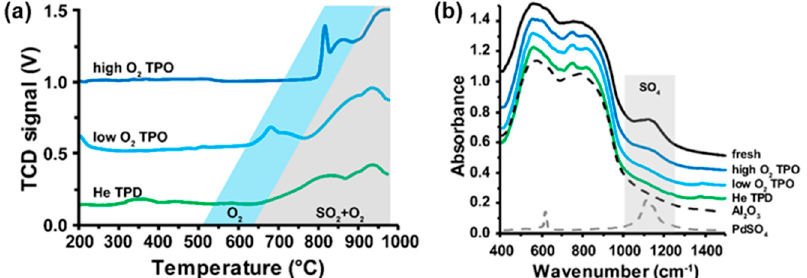
Figure 5. ( a ) Thermal decomposition curves of the PS/Al 2 O 3 model catalyst and ( b ) FTIR spectra of the PS/Al 2 O 3 model catalyst before and after decomposition, accompanied by reference spectra of bulk PdSO 4 and Al 2 O 3 .